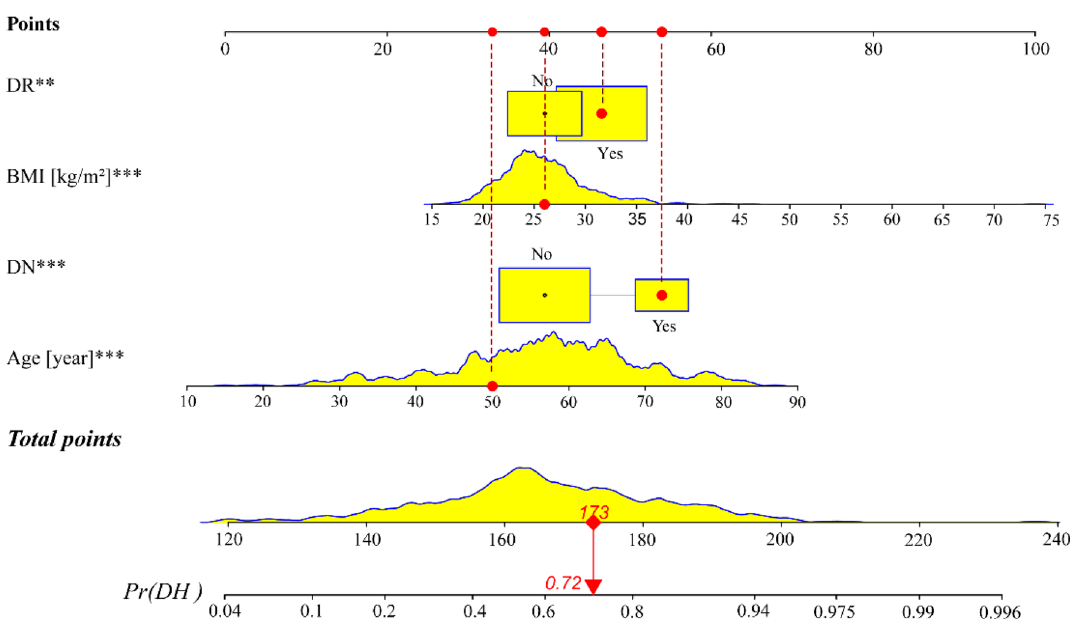
Figure 4. An example of a nomogram for DH. The yellow areas in the graph represent the distribution of the variables in the cohort. DN and DR are the highescoringsing, with relatively low scores for BMI and